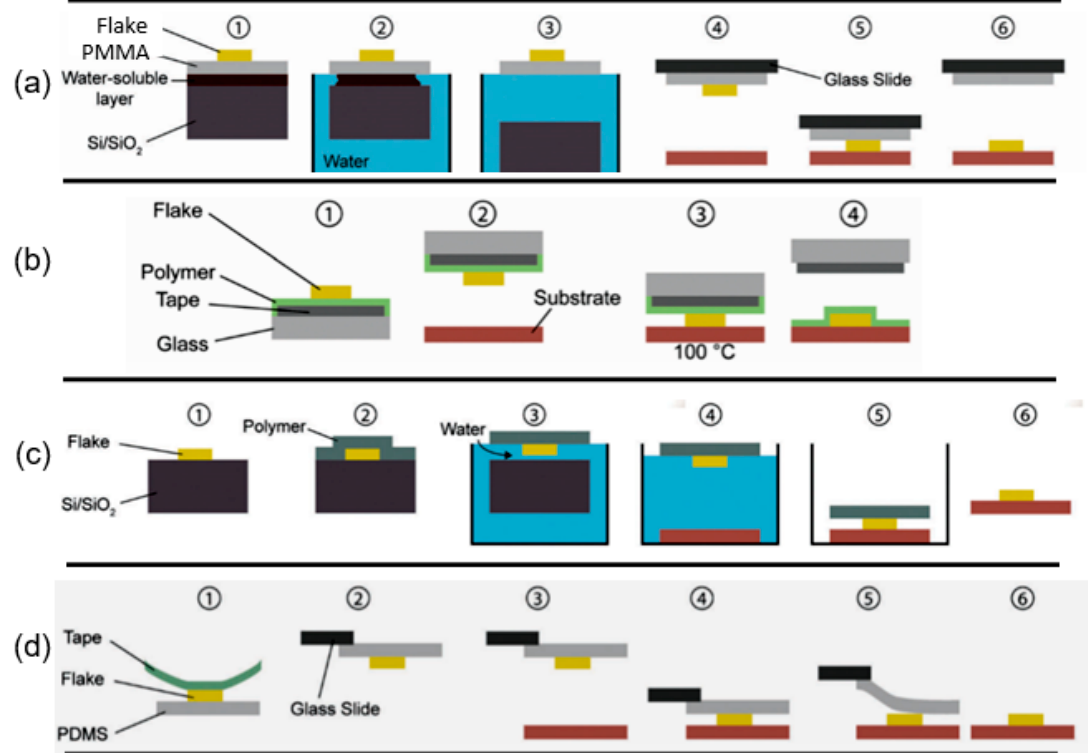
Figure 45. Illustration of transfer methods: ( a ) The PMMA carrying layer transfer method. The designated flake to be transferred is exfoliated onto a Si/SiO 2 substrate which has been coated with a water-soluble polymer layer and PMMA (1). The stack is then immersed in water (2) where the